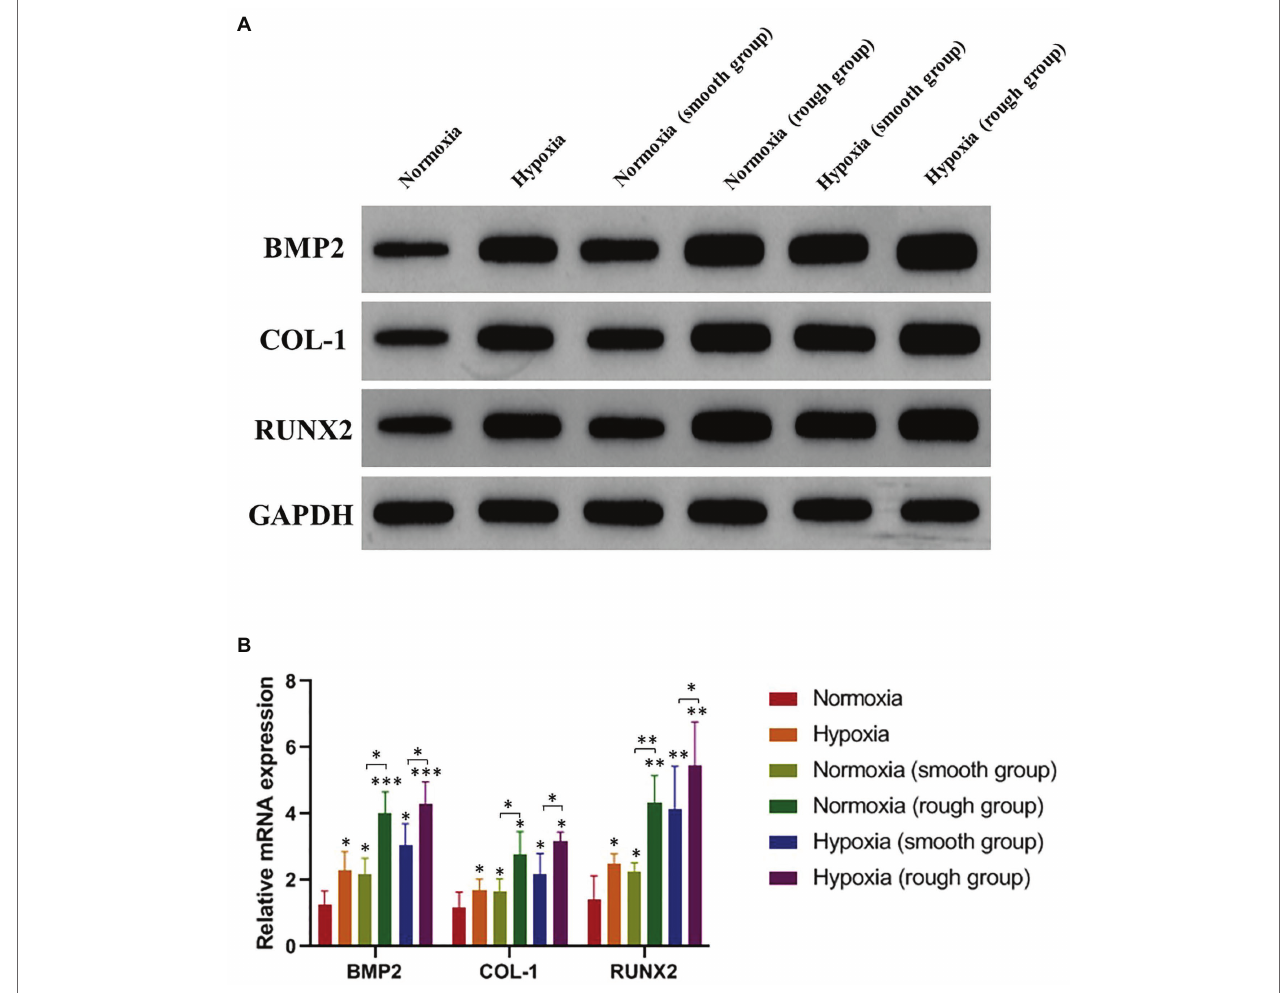
FIGURE 4 | Osteogenic-related proteins and mRNA (BMP2, COL-1, and RUNX2) expression of MG-63 cells in different groups. (A) Western blotting and (B) RT-qPCR. * p < 0.05, ** p < 0.01, and *** p < 0.001, * compared with the corresponding group maintained under normoxic